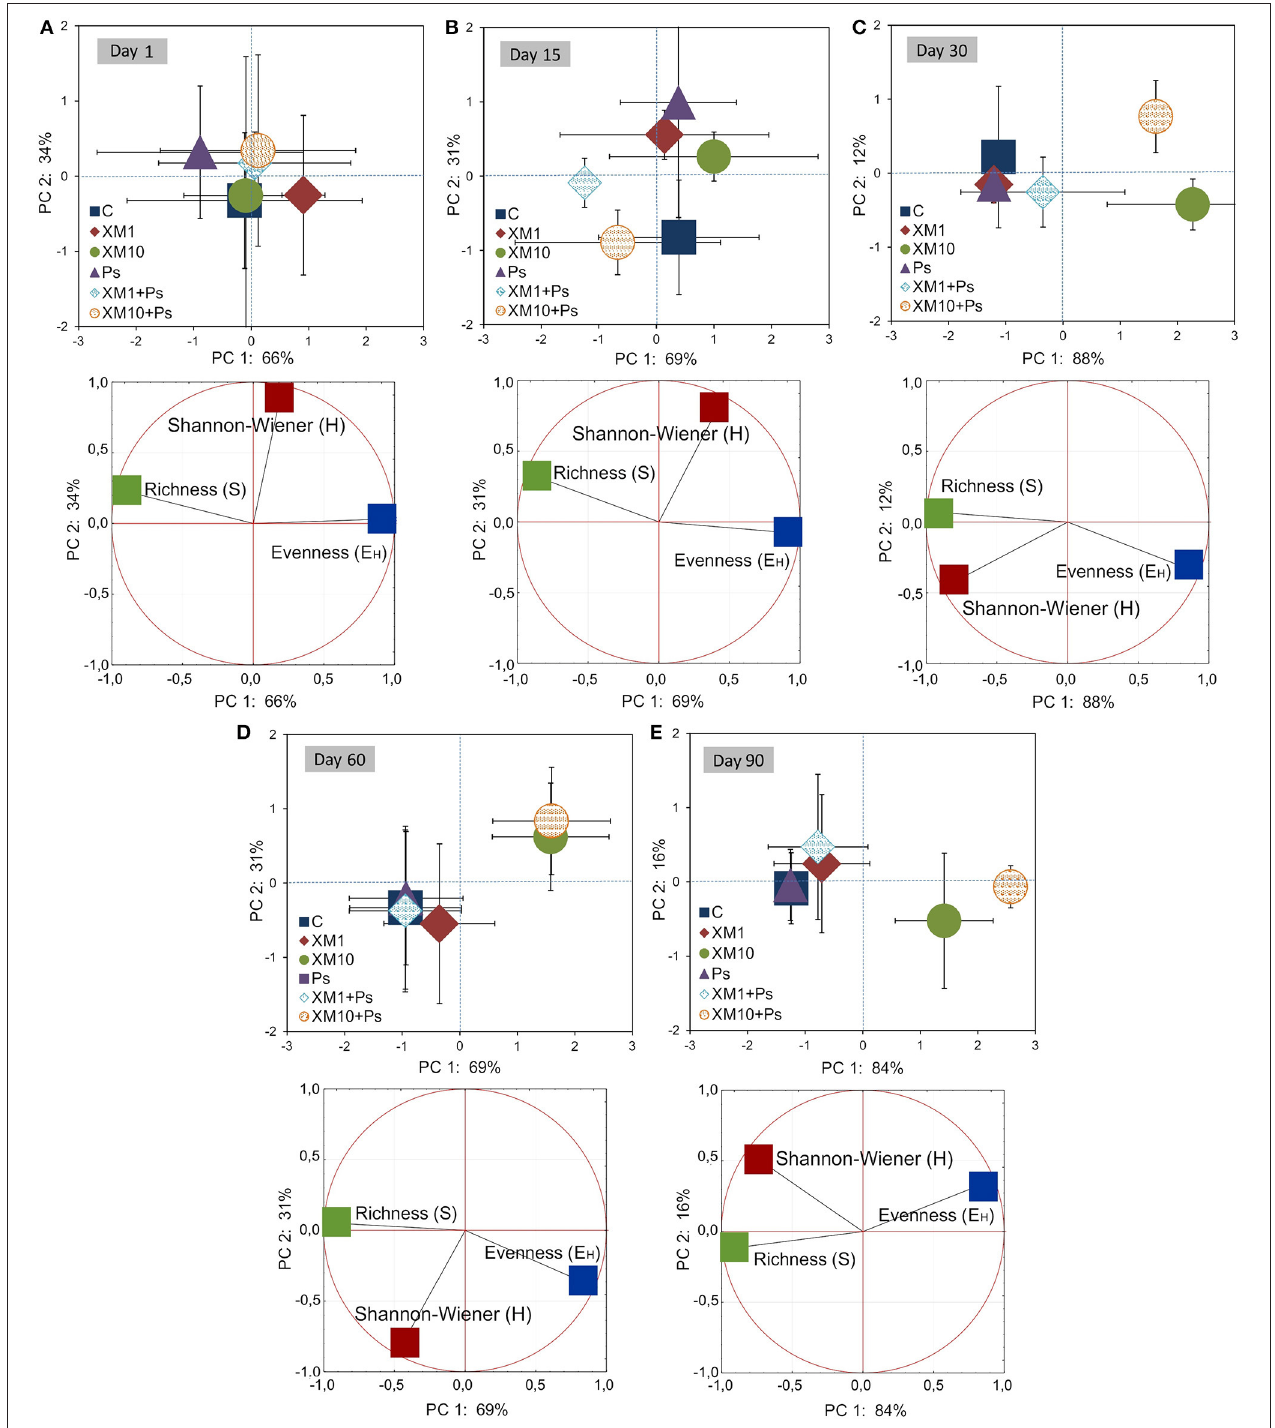
FIGURE 7 | PC plots for the DGGE indices obtained on days 1 (A) , 15 (B) , 30 (C) , 60 (D) , and 90 (E) . The explanation of the treatment abbreviations is given in Figure 3 .